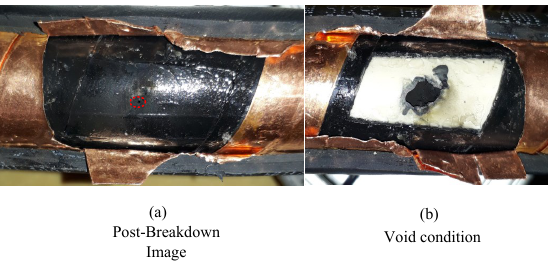
Figure 5. Snapshots of the test cable in different stages of the complete breakbown experiment: ( a ) Post-breakdown image; ( b ) Void